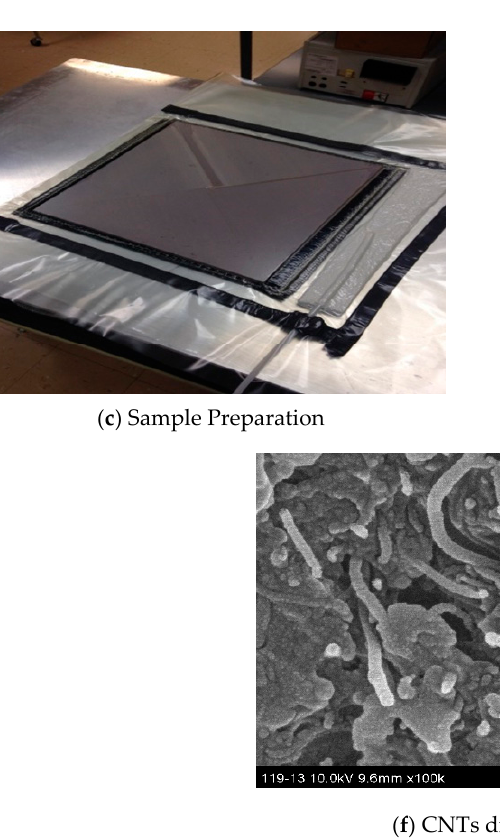
Figure 4. Specimens with different percentages dedicated to dynamic compression tests.